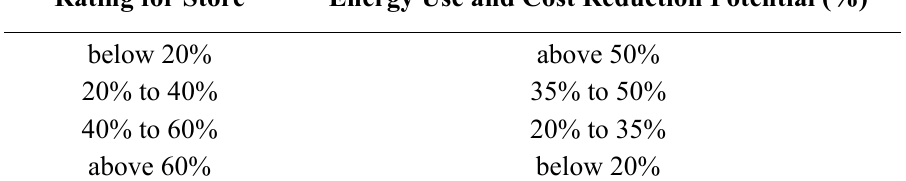
Table 2. EUI rating method using store ratings to determine saving